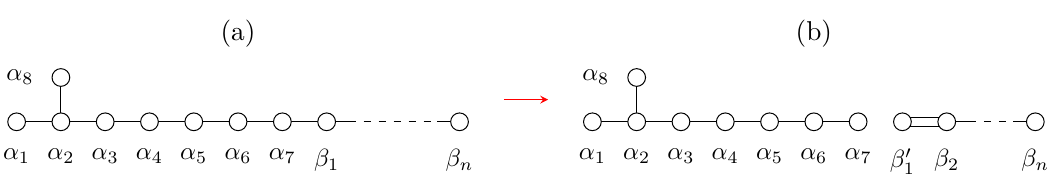
Figure 2 . (a) Primitive embedding of D 8 in Γ 2 , 18 with simple roots α i extended to D 8+ n by β j (see eqs. (2.12) and (2.13)). (b) Projection of the roots β j to the orthogonal complement of D 8 gives a C n lattice and associated sp algebra in the CHL n